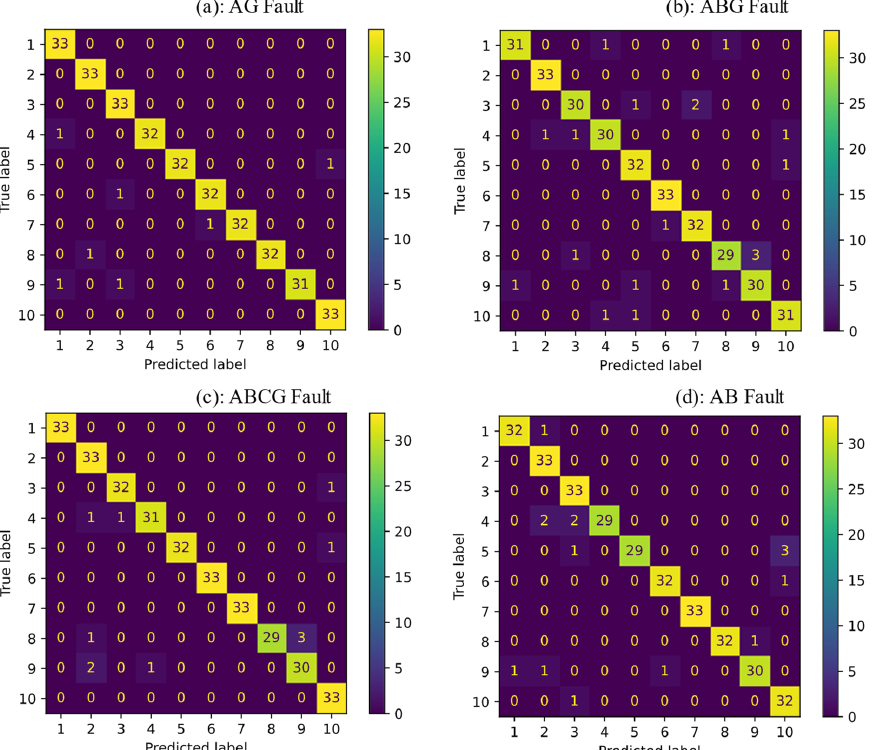
Figure 9. The confusion matrix for four types of fault scenarios, ( a ) Single-phase to ground fault, ( b ) Two-phase to ground fault, ( c ) Three-phase to ground fault, ( d ) Phase-to-phase fault. Table 3. The accuracy of SVM and KNN against different fault types.